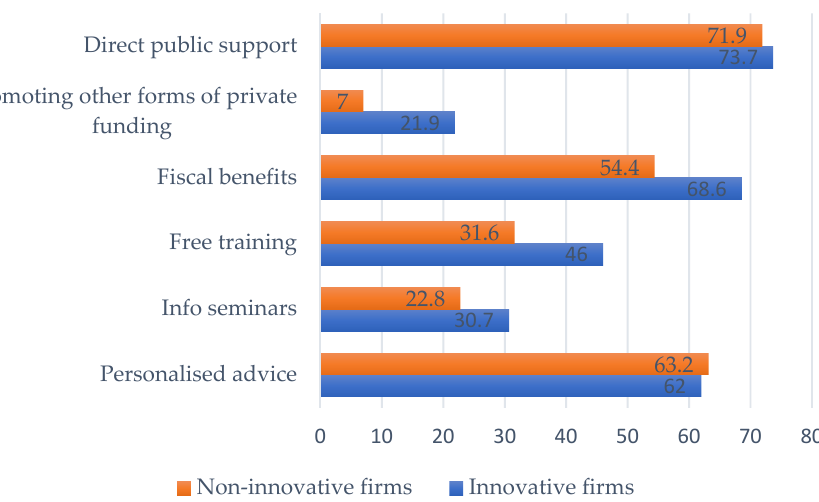
Figure 3. Demands for government actions (% innovative and non-innovative firms).